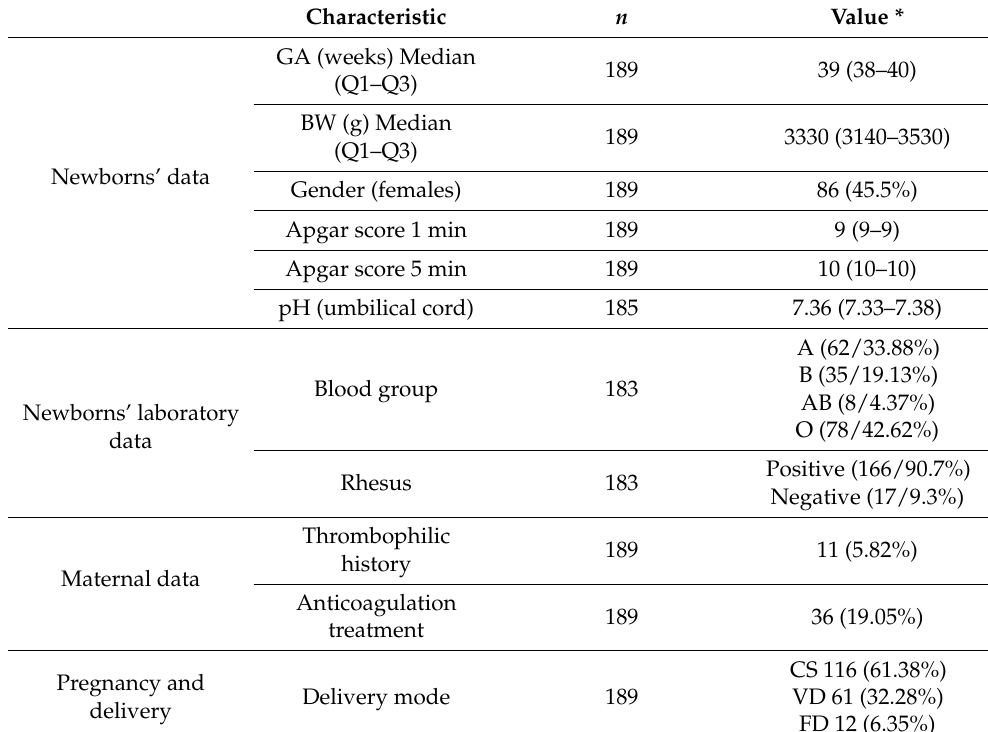
Table 1. Baseline characteristics of the study